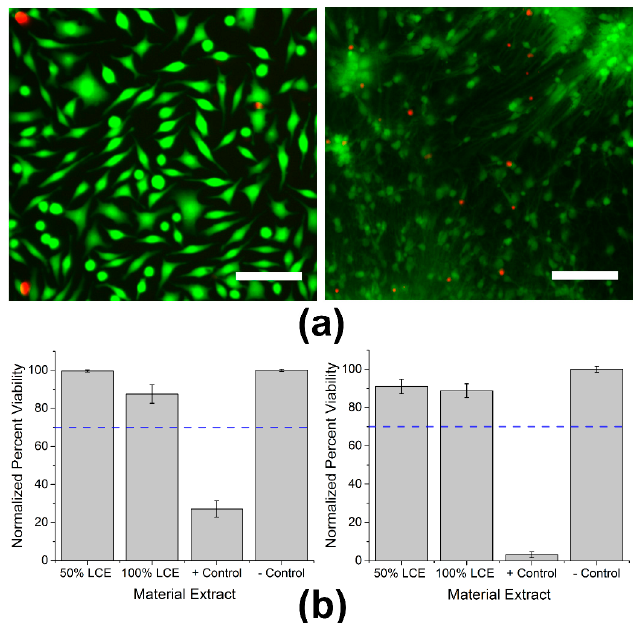
Figure 2. Cytotoxicity assays using both NCTC fibroblasts and primary cortical neurons: ( a ) Fluorescent images of NCTC fibroblasts ( left ) and primary murine-derived cortical neurons ( right ) stained with CaAM (green) for live cells and EthD-1 (red) for apoptotic cells. Scale bars represent 100 µ m ( b ) Mean normalized fibroblast ( left ) and cortical neuron ( right ) viability percentages of LCE extract at 50% and 100% concentrations, positive control, and negative control. Blue dotted line at 70% represents the ISO threshold set for non-cytotoxic materials.